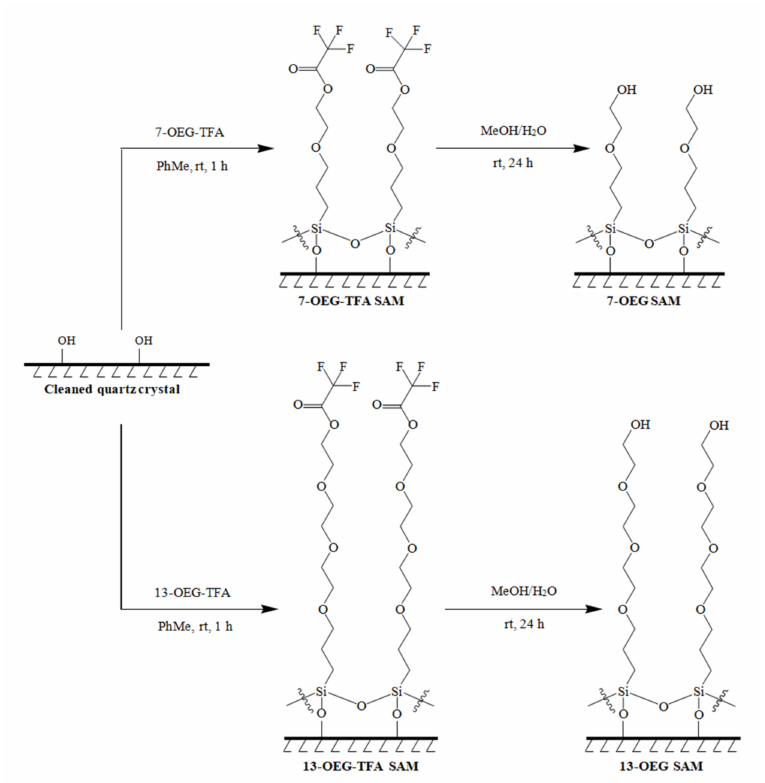
Figure 4. Surface attachment of 7–OEG–TFA and 13–OEG–TFA followed by cleavage of the protecting TFA Group. An identical protocol was employed for